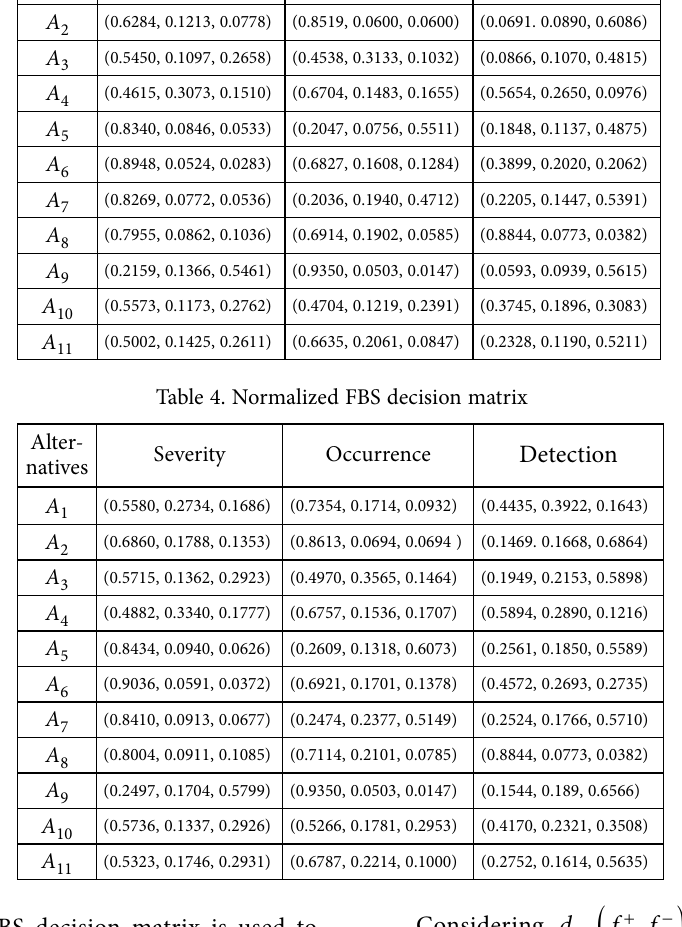
Table 3. Aggregated decision matrix Alter- Severity Occurrence Detection natives